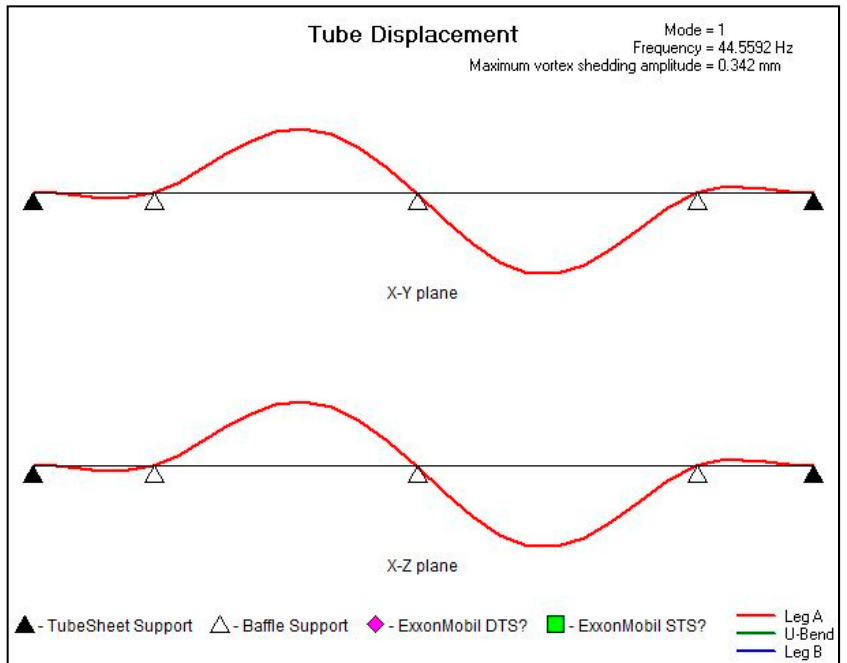
Figure 8. Tube displacement profiles of modes 1 and 2, 44.56 Hz (worst case).